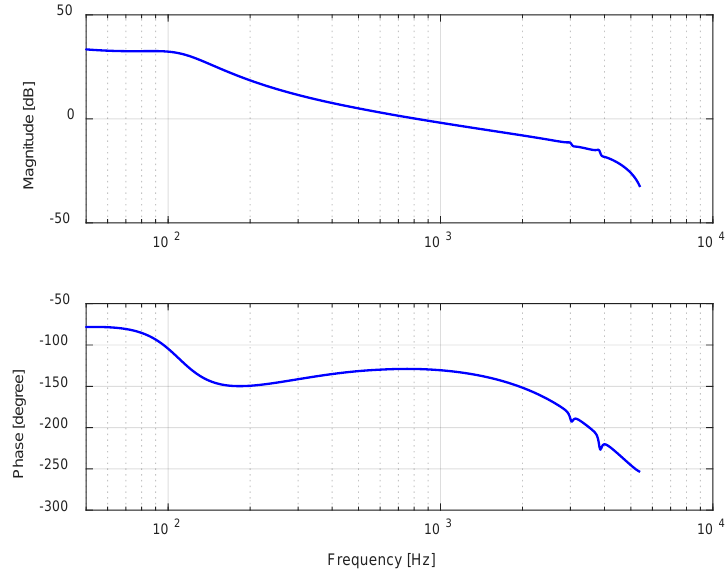
Figure 2. Open loop transfer function.